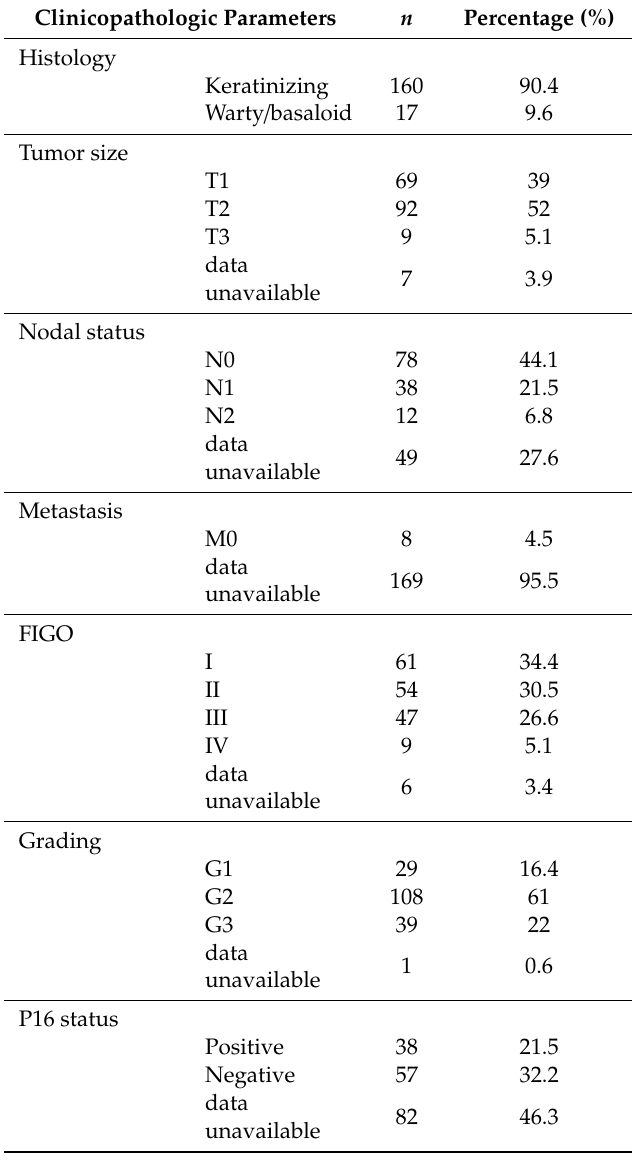
Table 1. Clinicopathological characteristics of the analyzed vulvar carcinoma